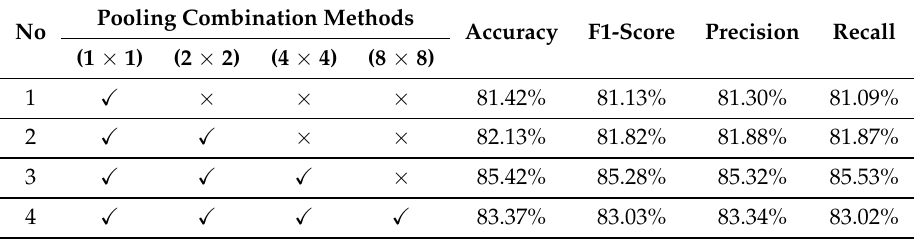
Table 4. Performance of pooling sizes in the face-level multi-scaled pooling